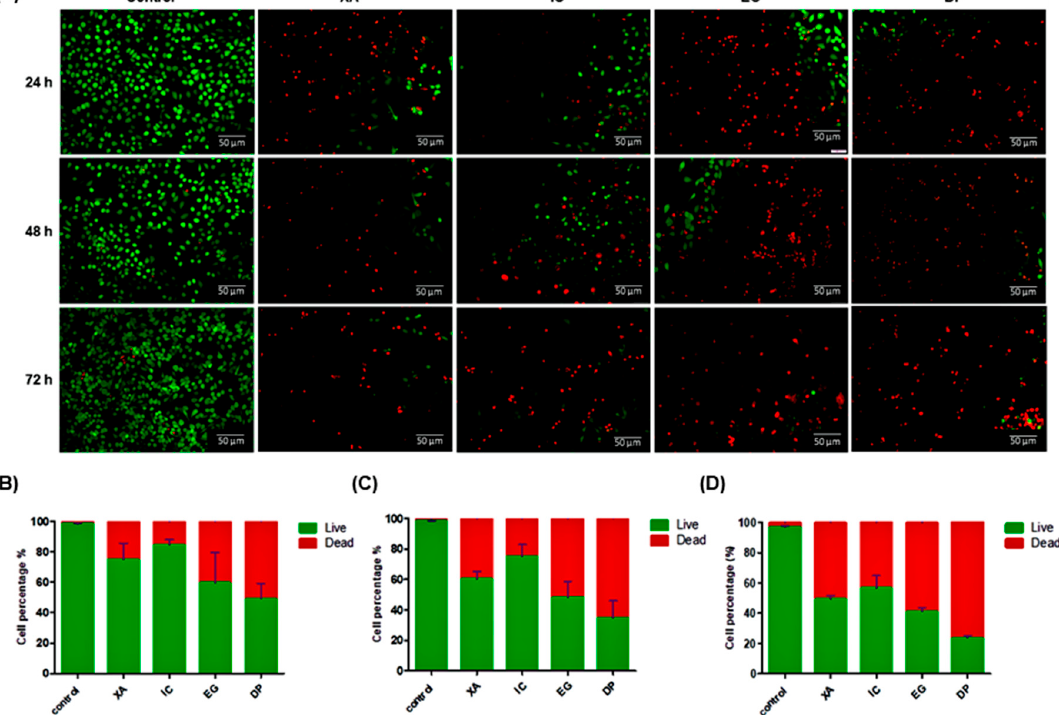
Figure 4. A live/dead assay after treatment of HeLa cells with the four studied extracts over 24, 48, and 72 h. ( A ) Green fluorescence denotes viable cells stained with calcein-AM, while red fluorescence represents dead cells stained with propidium iodide. Then, data analysis was performed using ImageJ software and Prism 5 ( B ) 24 h, ( C ) 48 h and ( D ) 72 h. All results are expressed as a total percentage of viable and dead cells from four random fields with mean ± standard deviation (SD) of three independent determinations. Scale bar represents 50 µm.